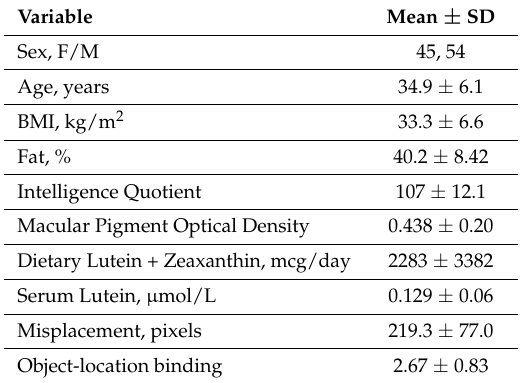
Table 1. Participant characteristics and memory performance.